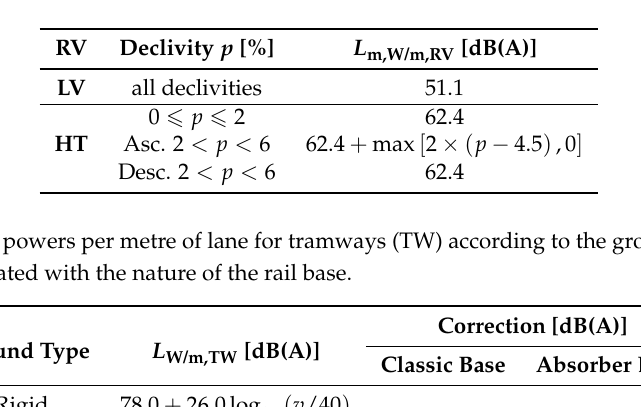
Table 4. Mechanical noise components of the emission powers per metre of lane for LV and HT at starting section according to the declivity p (in %, with Ascent (Asc.) and Descent (Desc) declivities) of the road segment.